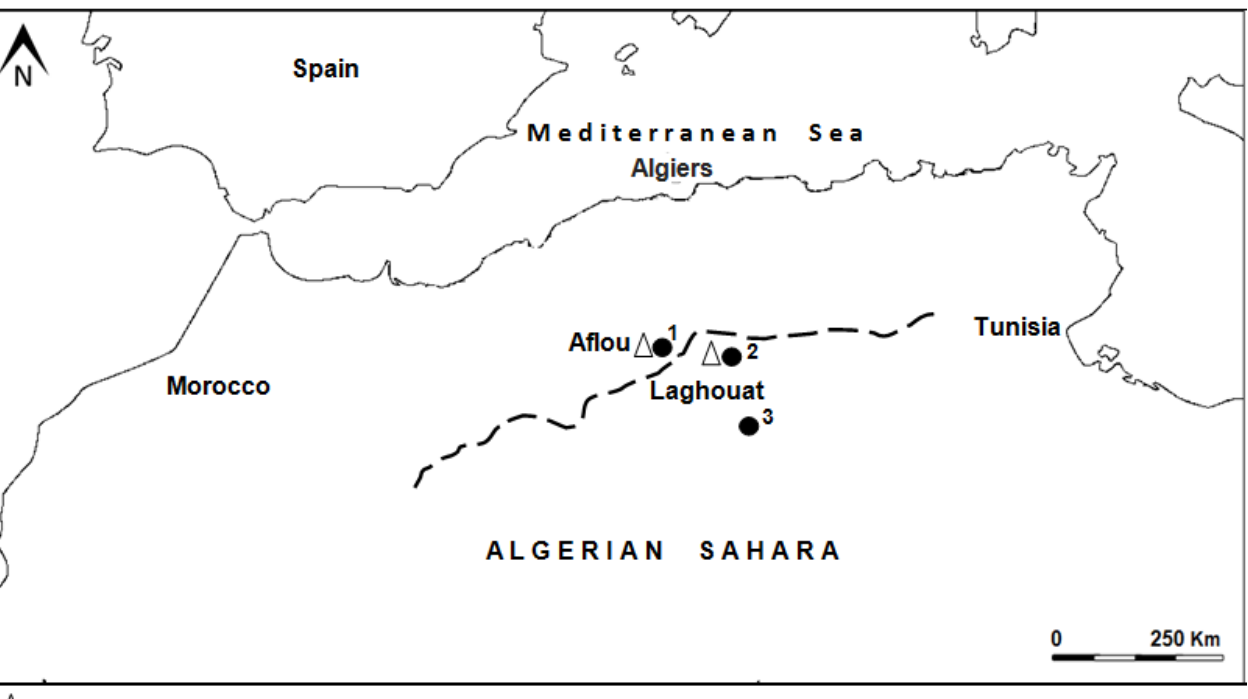
Fig 1. Geographic situation of study area (steppe of Algeria) and distribution of sampling